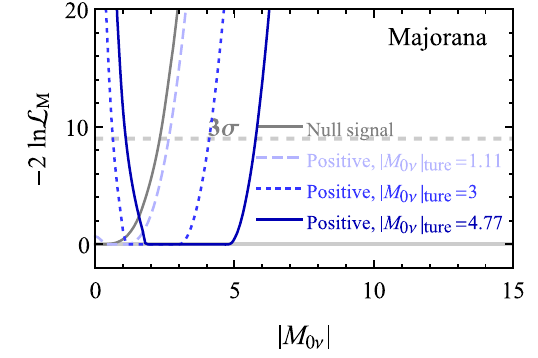
(cid:2) (cid:2) (cid:2) , in the presence of a (cid:2) M 0 ν = 0 eV (cid:2) (cid:2) 3 , true (cid:2) M (cid:2) = 1 . 11 (dashed blue curve), 3 (dotted 0 ν true